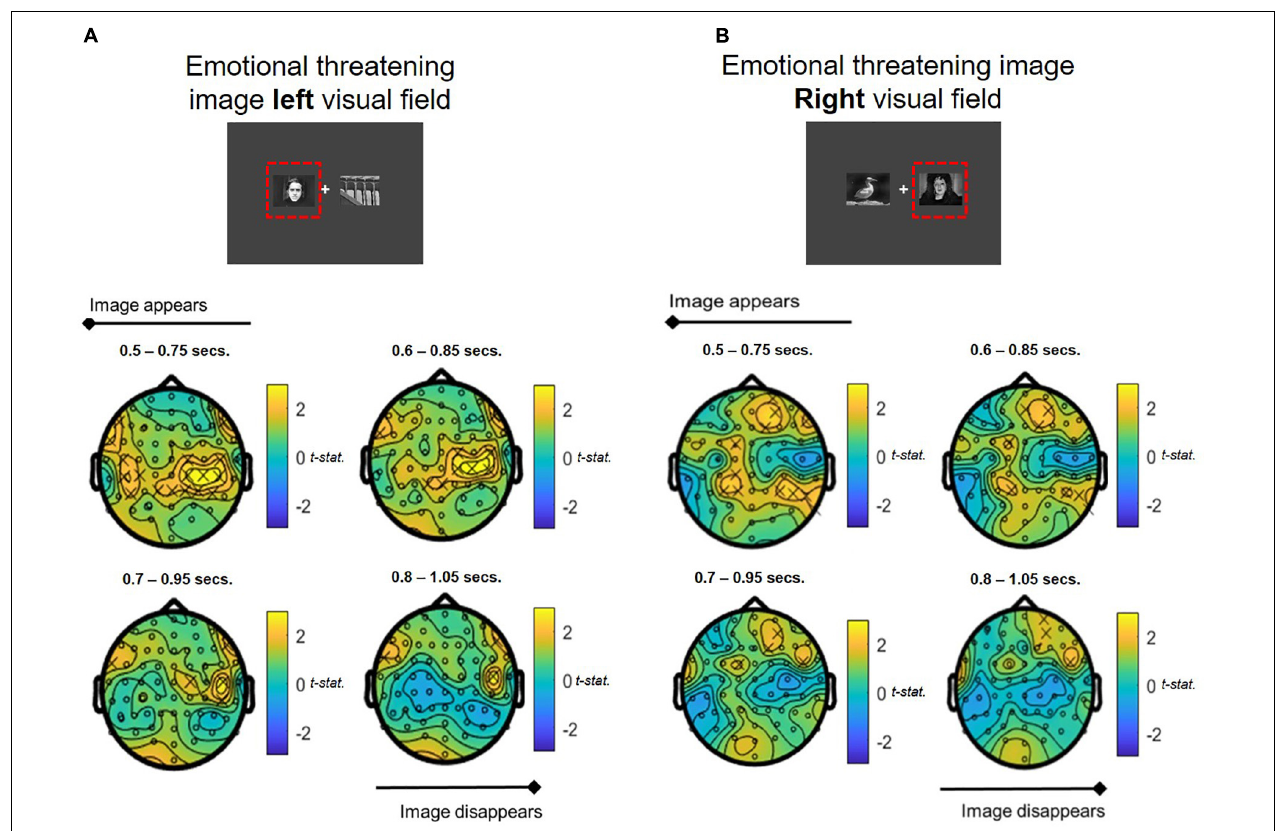
FIGURE 7 | Theta band power differences between COMBINED and PLACEBO treatments during presentation of emotionally threatening and neutral images when stress images shown in (A) LEFT and (B) RIGHT visual fields. Values > 0 indicate COMBINED treatment theta values are higher than PLACEBO treatment. Significant electrodes ( p < 0.05) marked with an x . Each figure depicts a series of T -tests along the time course of the presentation of the images (0.5–1.05 s, in 0.1 s steps, 0.25 s sample